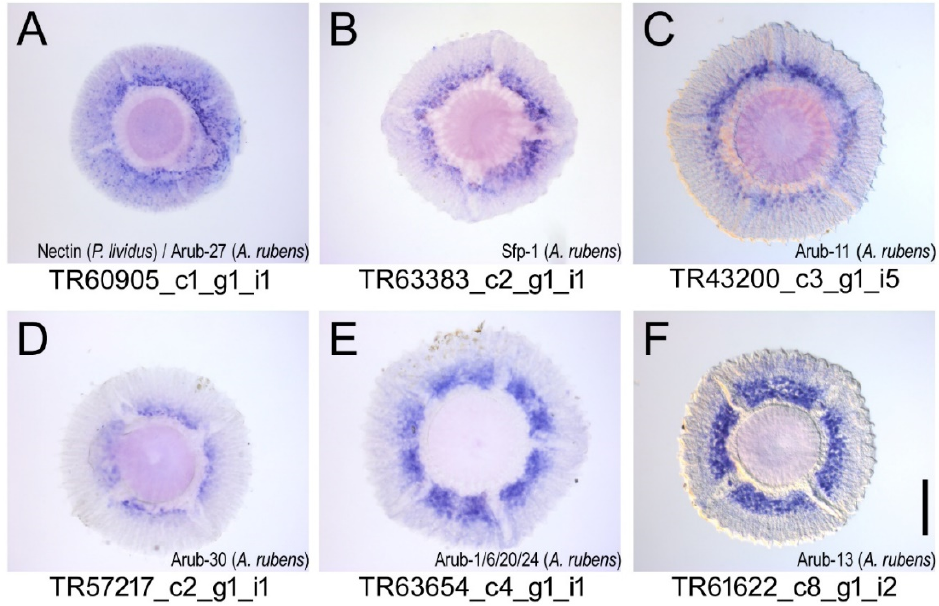
Figure 6. In situ hybridisation expression patterns of selected adhesion candidate genes previously identified in P. lividus ( A ) and in the sea star Asterias rubens ( B–F ). The respective BLAST hit for each transcript is shown on the bottom right of each image. Scale bar, 200 µm.